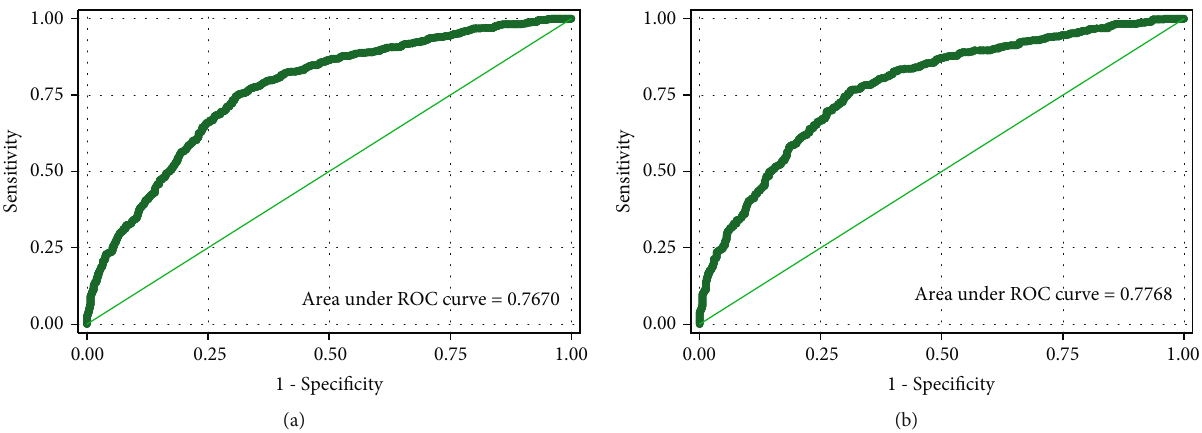
Figure 2: Receiver-operating characteristic (ROC) curves of the nomograms in the training (a) and testing (b) datasets. The nomogram had good discriminative power with an area under the ROC curve of 0.77 (95% con fi dence interval, 0.74 to 0.79) and 0.77 (95% con fi dence interval, 0.75 to 0.80) in the training and testing datasets, respectively. The discrimination is quanti fi ed by calculating the area under the ROC curve (AUC). An AUC of 0.5 indicates no discrimination, and an AUC of 1.0 represents excellent discrimination.